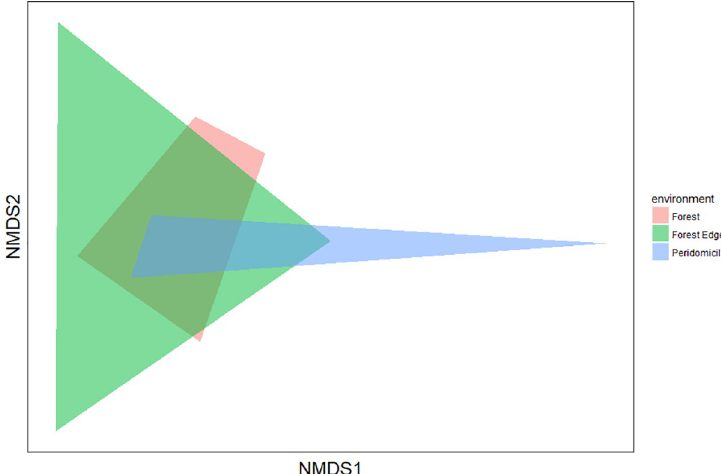
Fig 4. Non-Metric Multidimensional Scaling (NMDS) for the species collected in each environment of the Rio Pardo settlement, Presidente Figueiredo Municipality, Amazonas State, Brazil.